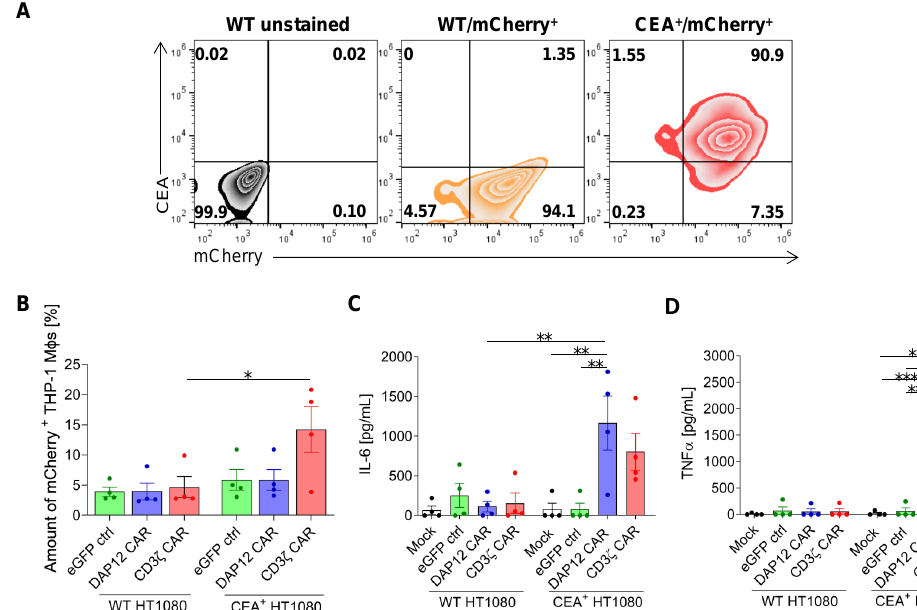
Figure 2. CAR-mediated cancer cell phagocytosis and cytokine secretion of THP-1-derived M Φ s. ( A ) Flow cytometric analyses of mCherry and CEA expression in HT1080 target cells. ( B ) Percentage of mCherry + M Φ s after co-culture with target cells analyzed by flow cytometry ( n = 4). ELISA assays showing ( C ) IL-6 and ( D ) TNF α secretion by THP-1-derived M Φ s after co-culture with WT/mCherry + or CEA + /mCherry + HT1080 cells. Data ( C , D ) are represented as the mean ± s.e.m. of n = 4 biological replicates measured in duplicate. Statistical significance was calculated with one-way ANOVA using multiple comparisons (*** indicates p < 0.001, ** indicates p < 0.01, and * indicates p < 0.03). Mock: untransduced THP-1-derived M Φ s, ctrl: